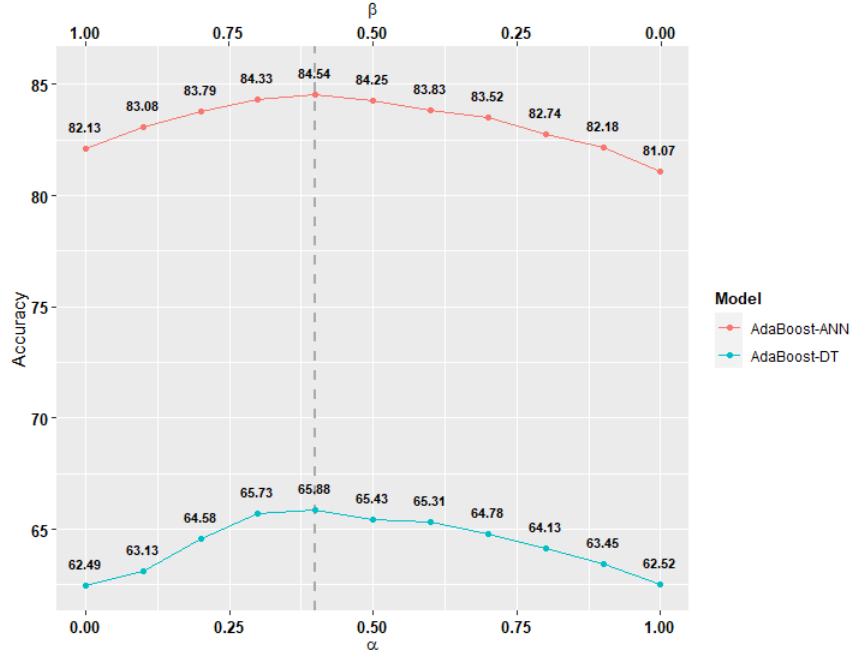
Figure 8. The average models’ accuracy as the values of α and β